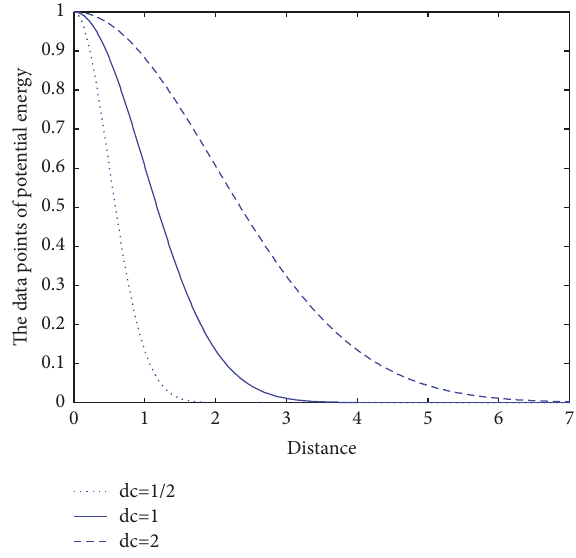
Figure 1: Gauss field potential